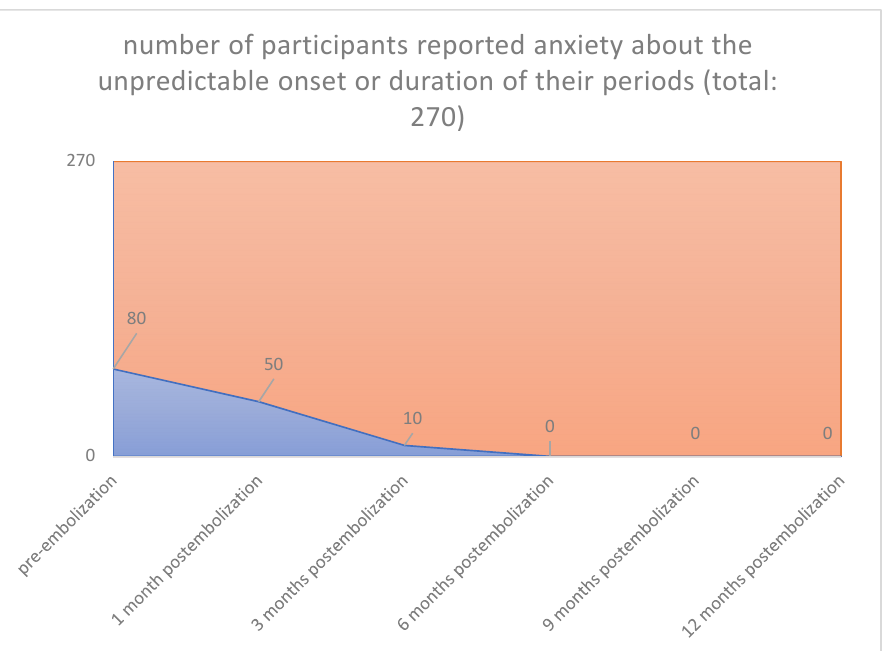
Figure 5. Dysmenorrhea and dyspareunia: Pre-embolization 110 from 270 participants reported dysmenorrhea and dyspareunia. 1 Month 60 from 110 participants reported decrease in dysmenorrhea and dyspareunia. 3 Months 90 from 110 participants reported decrease in dysmenorrhea and dyspareunia. 6 Months 110 from 110 participants reported decrease in dysmenorrhea and dyspareunia. 9 Months 110 from 110 participants reported decrease in dysmenorrhea and dyspareunia. 12 Months 110 from 110 participants reported decrease in dysmenorrhea and dyspareunia.